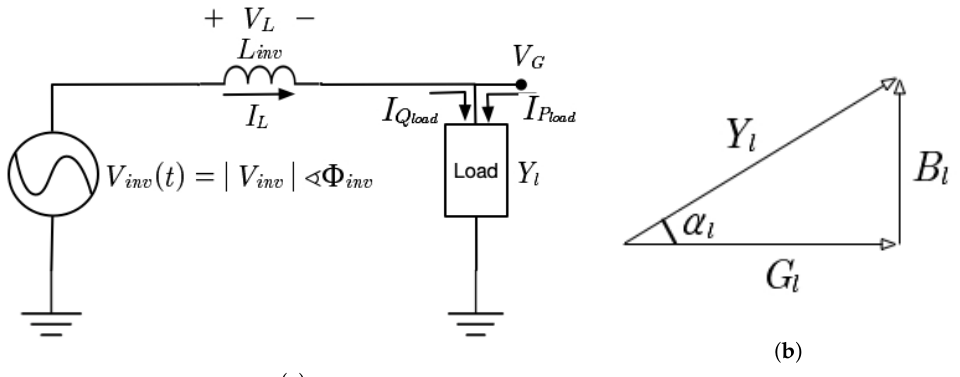
Figure 3. Reactive power compensation mode: ( a ) Circuit model, ( b ) Phasor diagram.